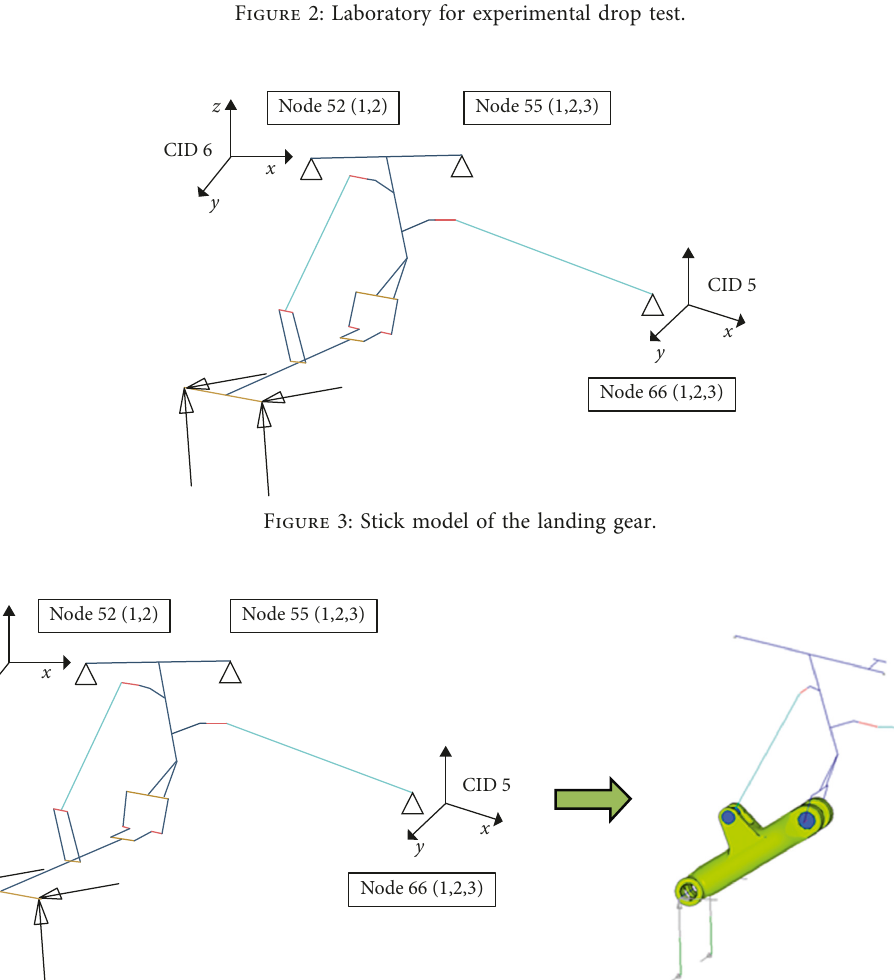
Figure 4: Global/local technique.